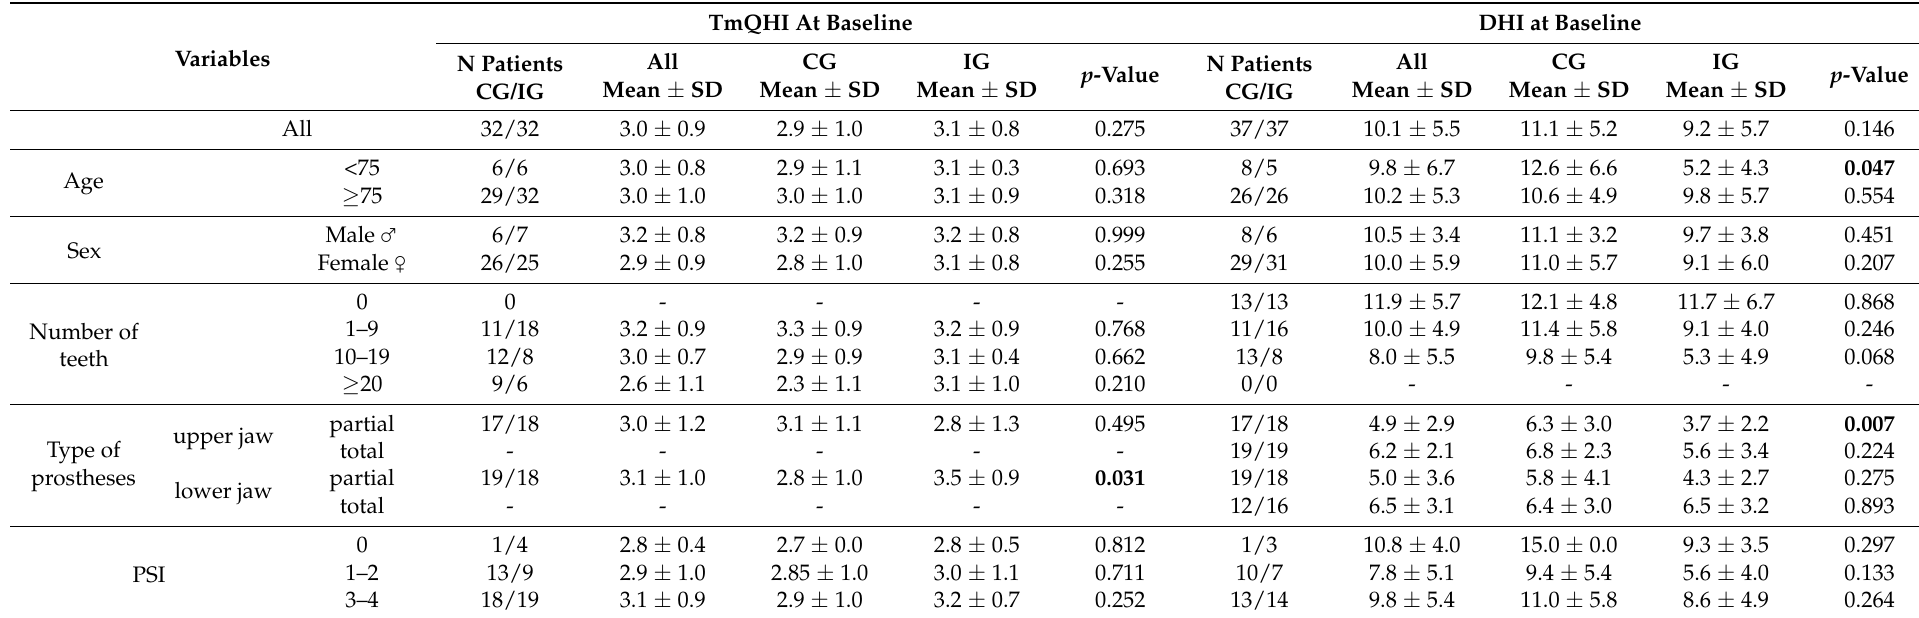
Table 2. Turesky-modified Quigley–Hein index (TmQHI) and denture hygiene index (DHI) at baseline